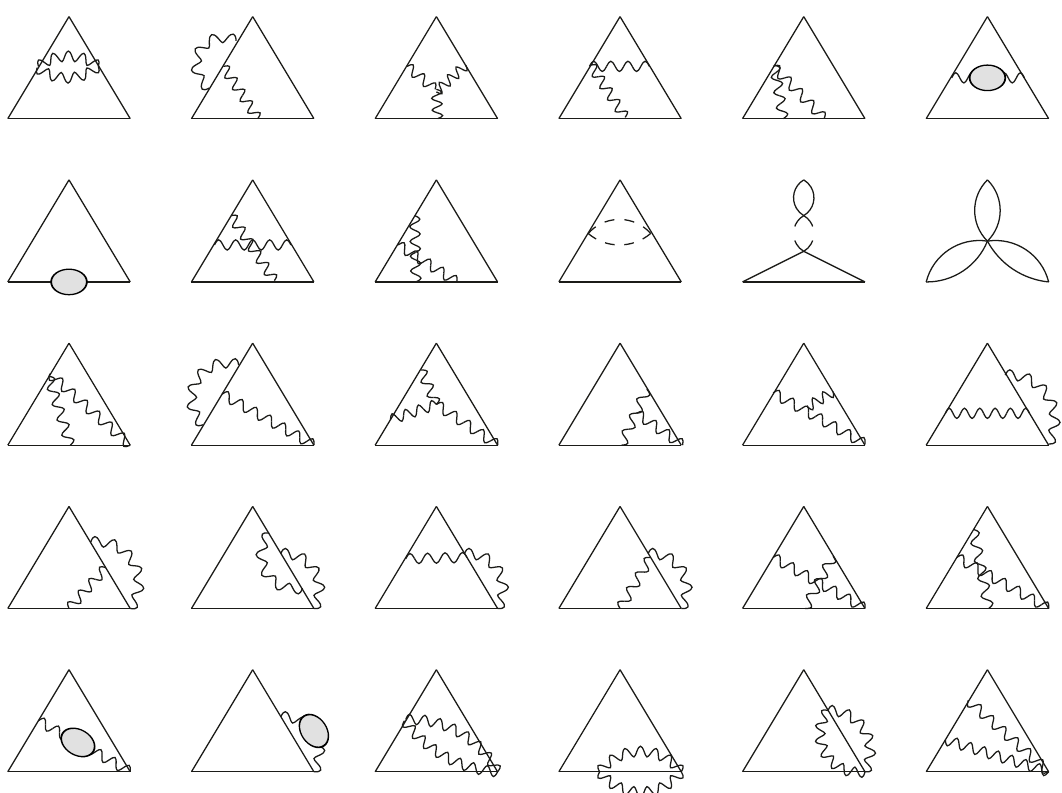
Figure 9. Diagrams contributing to the three-point function of two chiral primary twist-one operators and one with spin at position 3, which is the lower-right corner of the triangles. Solid, dashed and wavy lines represent scalars, fermions and gluons, respectively. Only non-vanishing diagrams are shown, though some of them do vanish when applying the integration method on one of the external insertion points. Blobs represent self-energy corrections, two-loop for the scalar (cid:12)eld and one-loop for the gauge propagator. The complete expression for the former can be found in [90, 91]. Part of the diagrams emerge from the gauge (cid:12)eld entering the covariant derivatives applied to the operator with spin. These diagrams are not present in the analogous computation for three chiral primary